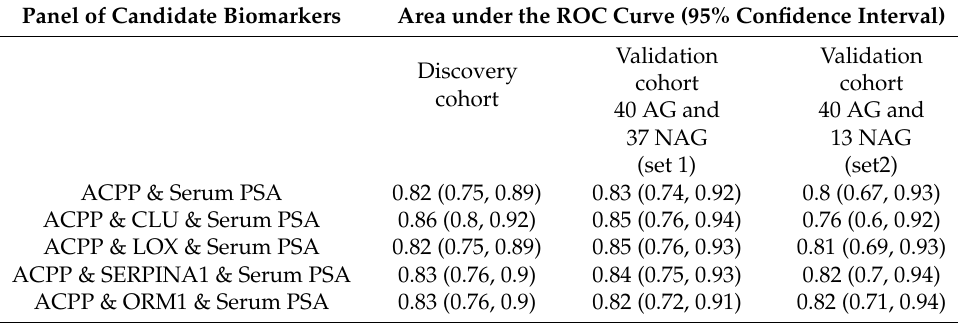
Table 2. AUC values obtained by different combinations of candidate biomarkers in the discovery and validation cohorts